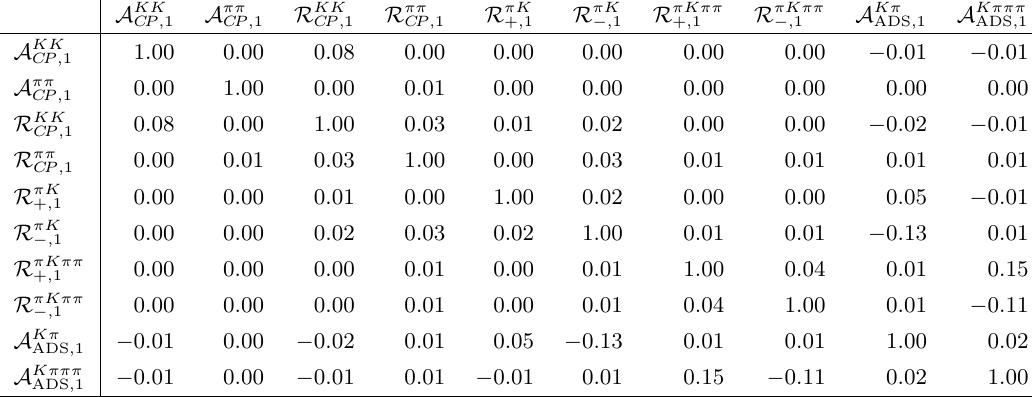
Table 5 . Combined statistical and systematic correlation matrix for the principal observables in Run 1 data